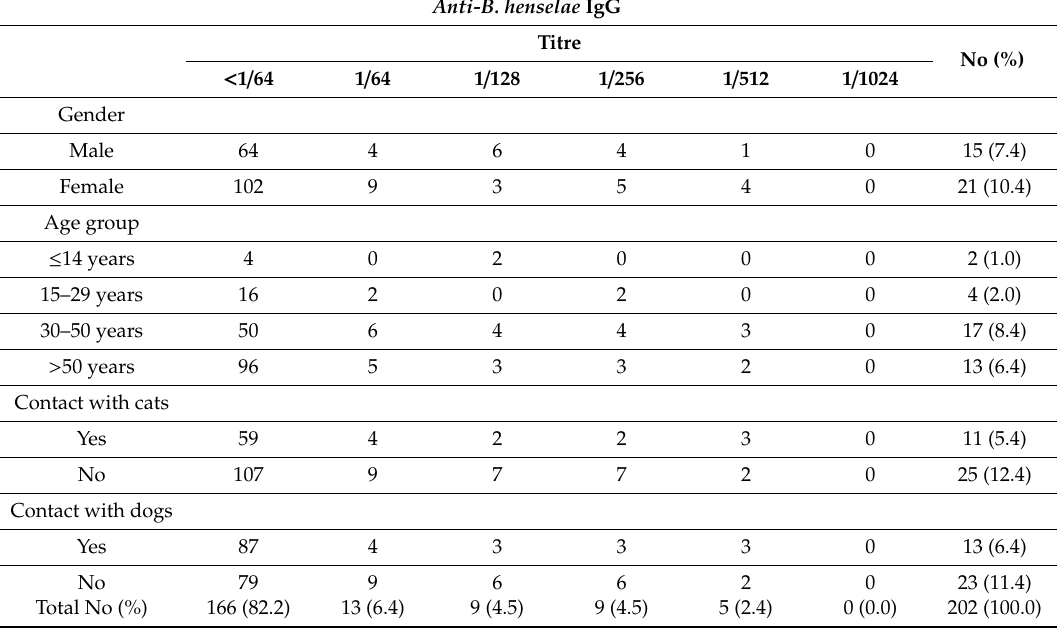
Table 1. IgG antibodies against Bartonella henselae and Rickettsia typhi by Gender, Age Group and Contact with Companion Animals (N =